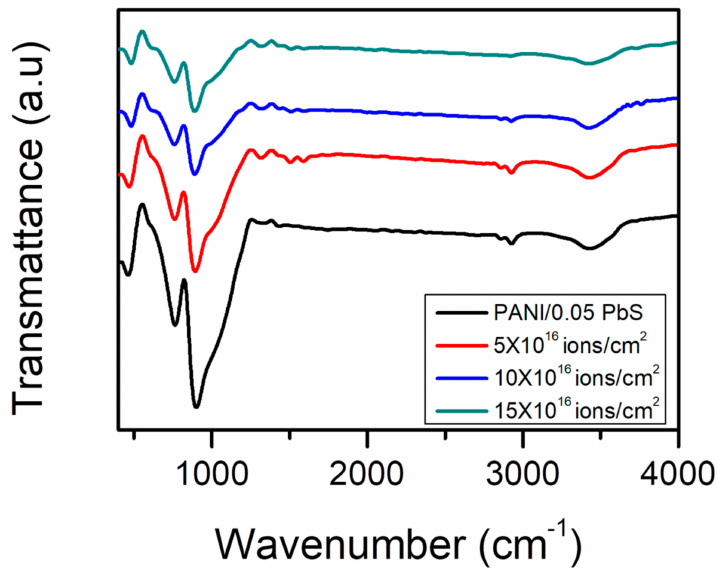
Figure 4. FTIR of the untreated and irradiated PANI/PbS samples.